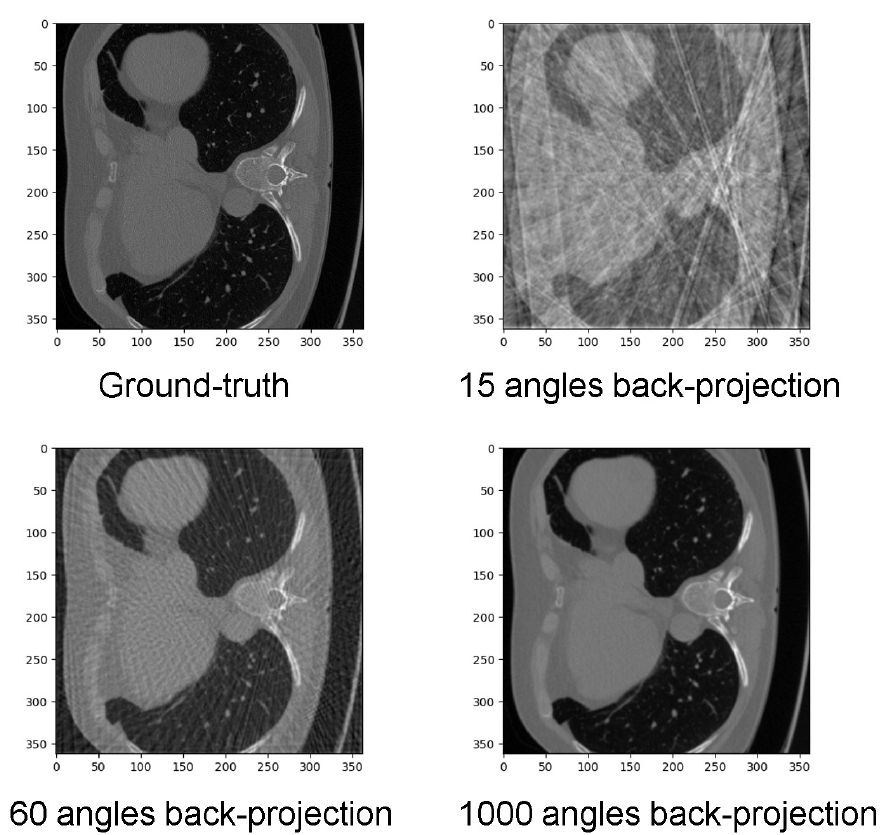
Figure 7. FBP results with different projection